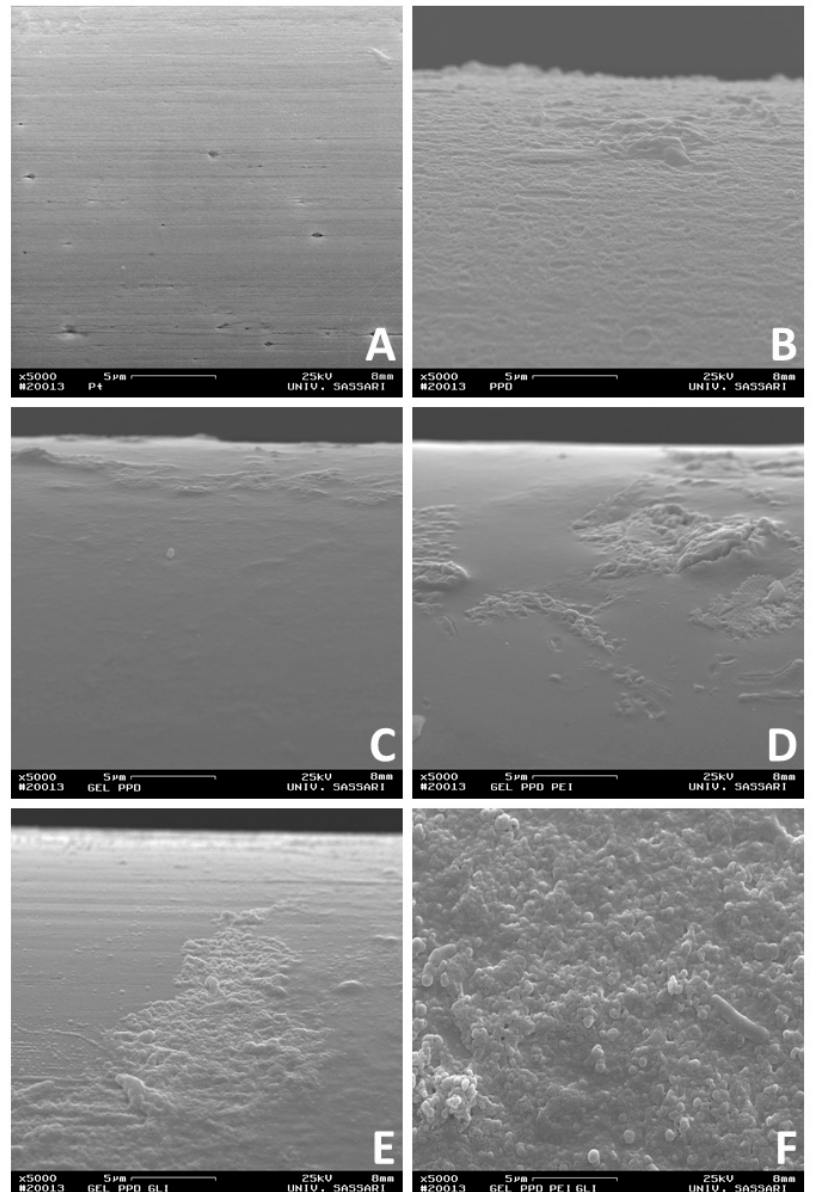
Figure 4. Scanning electron microscope (SEM) of different sensor configurations at 5000X magnification. Ptc (Panel A ); Ptc/PPD (Panel B ); Pt c /GEL(5%)/PPD (Panel C ); Pt c /[GEL (5%) + PEI (1%)] 5 /PPD (Panel D ); Pt c /[GEL (5%) + GLY (1%)] 5 /PPD (Panel E ); Pt c /GEL (5%) + GLY (1%) + PEI (1%)] 5 /PPD (Panel F ).